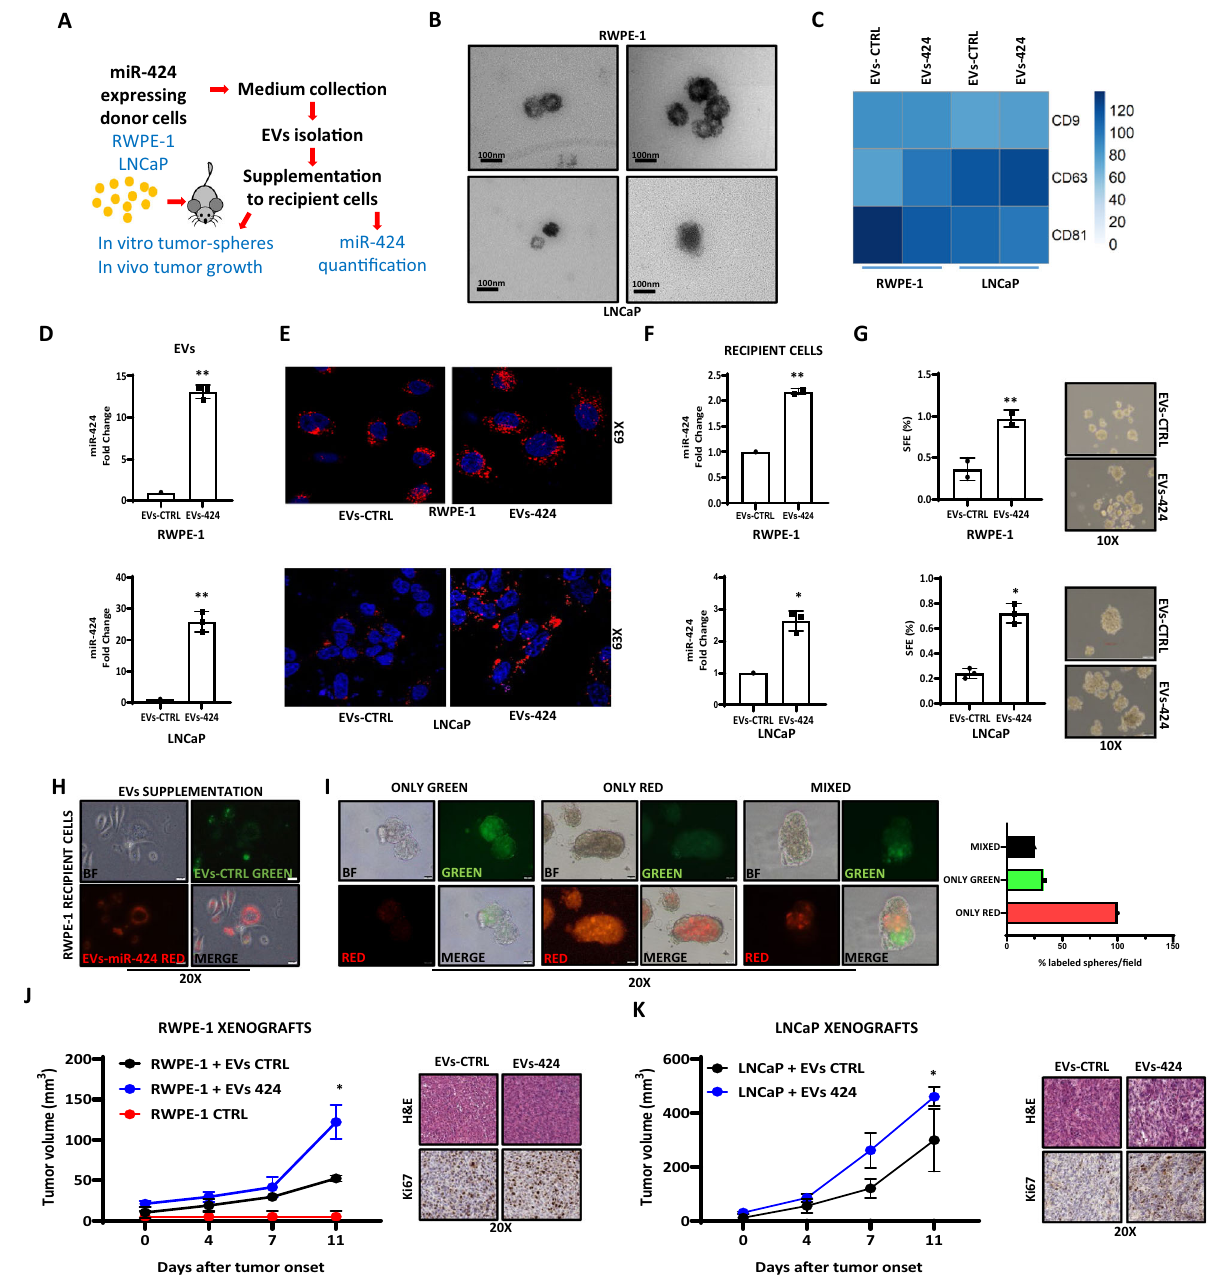
Fig. 3 EVs-secreted miR-424 drives the acquisition of stem cell traits and in vivo tumorigenesis. A Schematic of EVs isolation and functional characterization. B Representative image of transmission electron microscopy (TEM) of cell line-derived EVs. C EV-surface markers in cell line-derived EVs by MACSPlex analysis. D miR-424 levels in EVs derived from RWPE-1 and LNCaP cells with (EVs-424) and without (EVs-CTRL) stable expression of miR- 424. E Visualization of recipient cells incubated with fl uorescently labeled EVs (PKH26, red) from RWPE-1 and LNCaP donor cells by confocal microscopy. Nuclei were stained with Hoechst (blue). F Level of miR-424 in RWPE-1 (upper) and LNCaP (lower) recipient cells incubated with EVs-CTRL or EVs-424. G Tumor-sphere formation by RWPE-1 (upper) and LNCaP (lower) cells supplemented with EVs-CTRL or EVs-424. H Confocal microscopy images of RWPE- 1 recipient cells incubated for 24 h with EVs-CTRL or EVs-424 labeled with PKH67 (green) or PKH26 (red) fl uorescent dyes. I Confocal microscopy images of tumor-spheres formed by RWPE-1 cells incubated with fl uorescently labeled EVs as above. Right: quanti fi cation of fl uorescently labeled tumor-spheres. J Growth of subcutaneous xenografts of RWPE-1 cells supplemented in vitro with EVs-CTRL and EVs-424 derived from stably expressing donor LNCaP cells. n = 4/group. K Tumor growth of LNCaP cells supplemented in vitro with EVs-CTRL and EVs-424 derived from stably expressing LNCaP donor cells. n = 4/ group. Right panels, H&E and IHC staining for Ki67 in xenograft explants.* p ≤ 0.05, ** p ≤ 0.01 by two-tailed Student ’ s t -test.